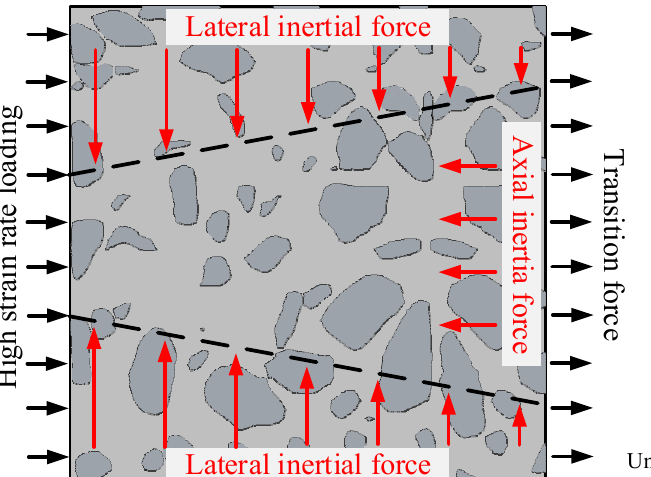
Figure 1. Inertia mechanism of specimen.